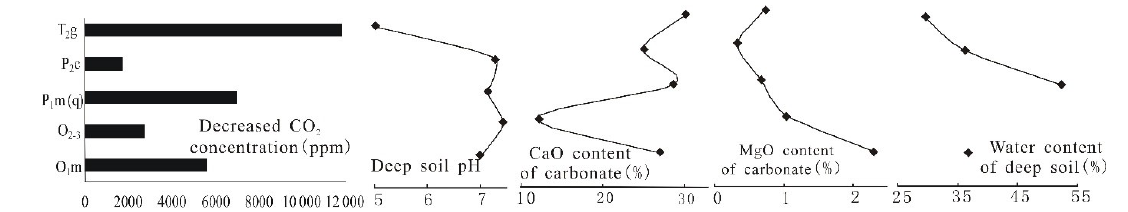
Figure 11. Relationship of the decreased CO 2 concentration and deep-soil pH, water content, CaO, and MgO contents of carbonate.